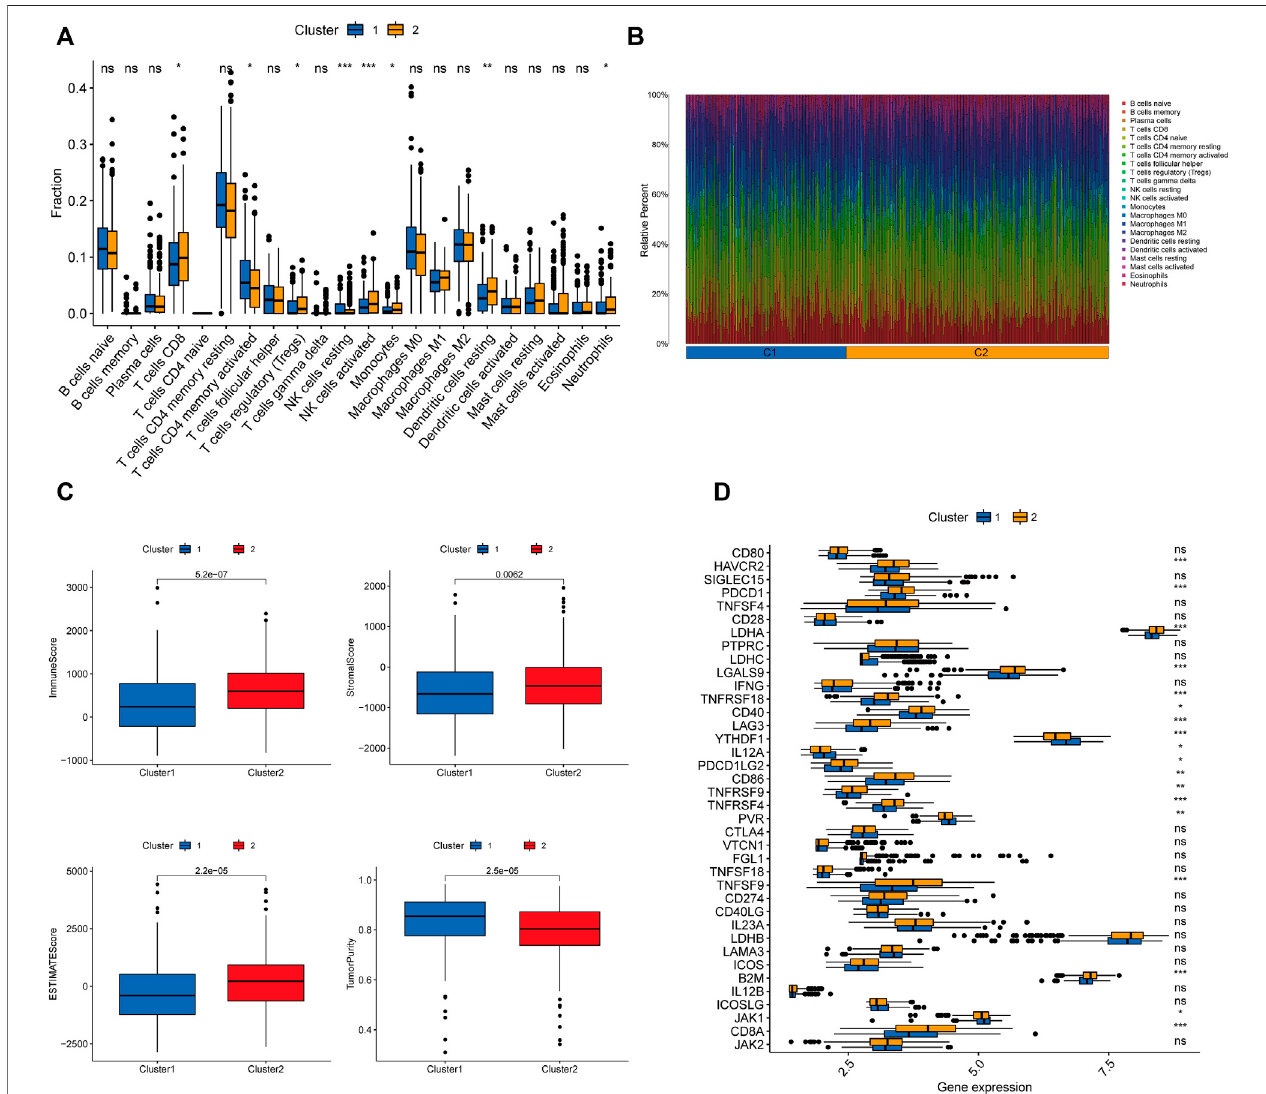
FIGURE 5 | Characterization of TME cell in fi ltration in different clusters. (A) CIBERSORT analysis of the abundance of 22 tumor-in fi ltrating immune cells (TICs) in fi ltration between the two groups. (B) The bar graph displaying the ratio of 22 TICs types for CC patients in cluster 1 and cluster 2. (C) The violin plots depicting the differenceintumormicroenvironmentscores(includingimmunescore,stromalscore,ESTIMATEscore,andtumorpurity)betweenthetwoclusters. (D) Expressionof32 immune checkpoint genes between the two clusters. p p < 0.05; pp p < 0.01; ppp p < 0.001;ns, no sense.